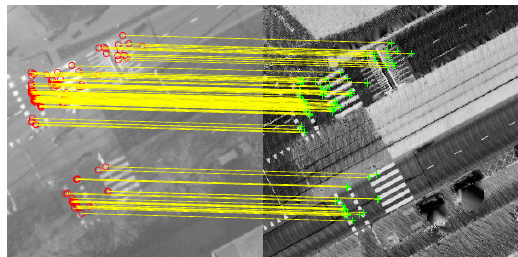
Figure 14. Homography based outliers filtering.